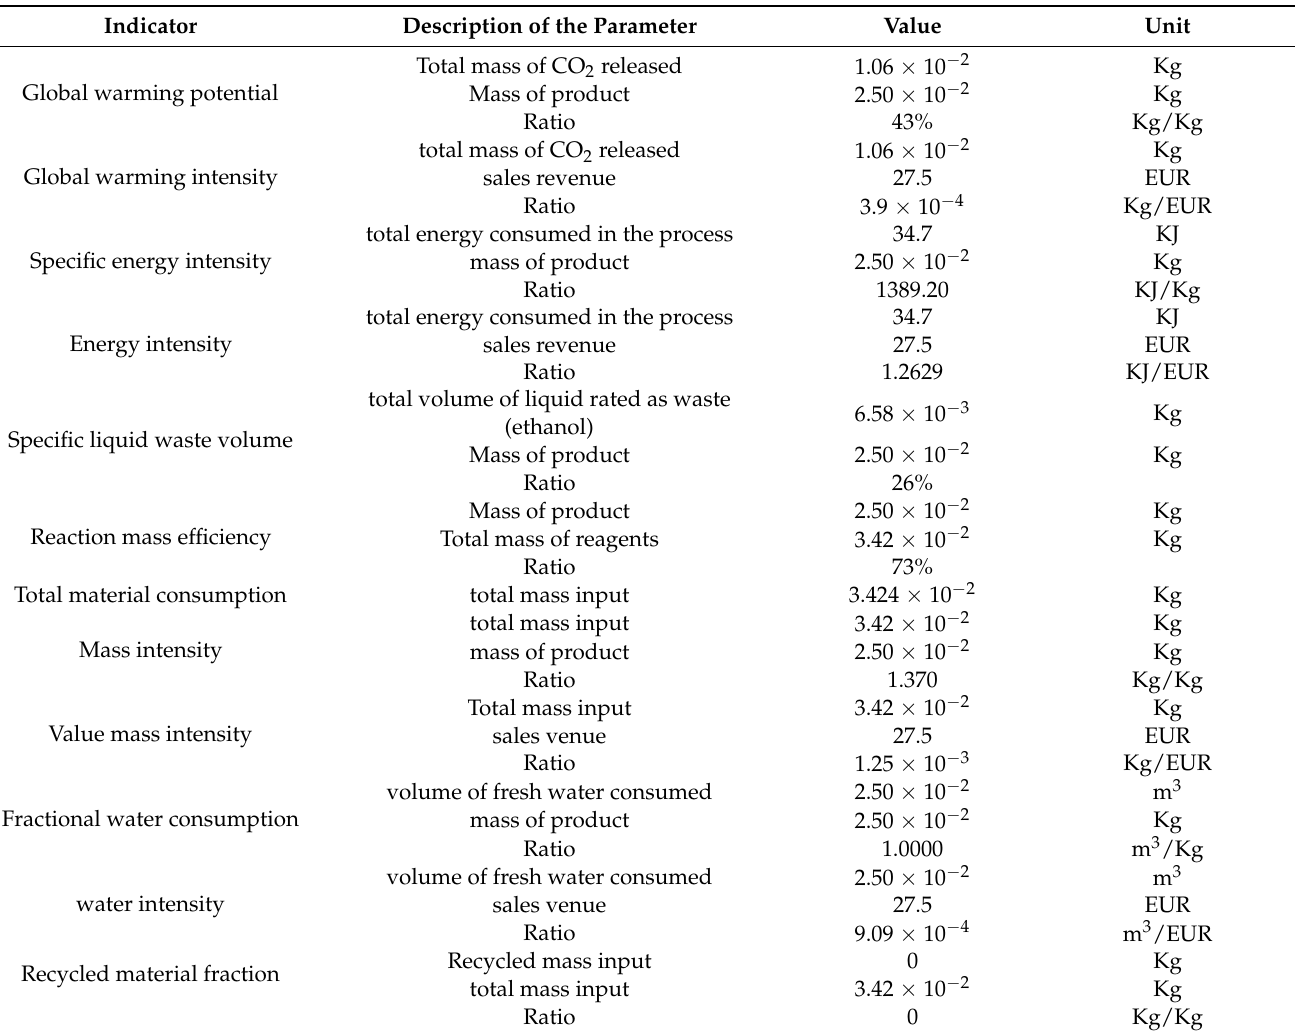
Table 3. List of actual values calculated for each sustainability indicator.